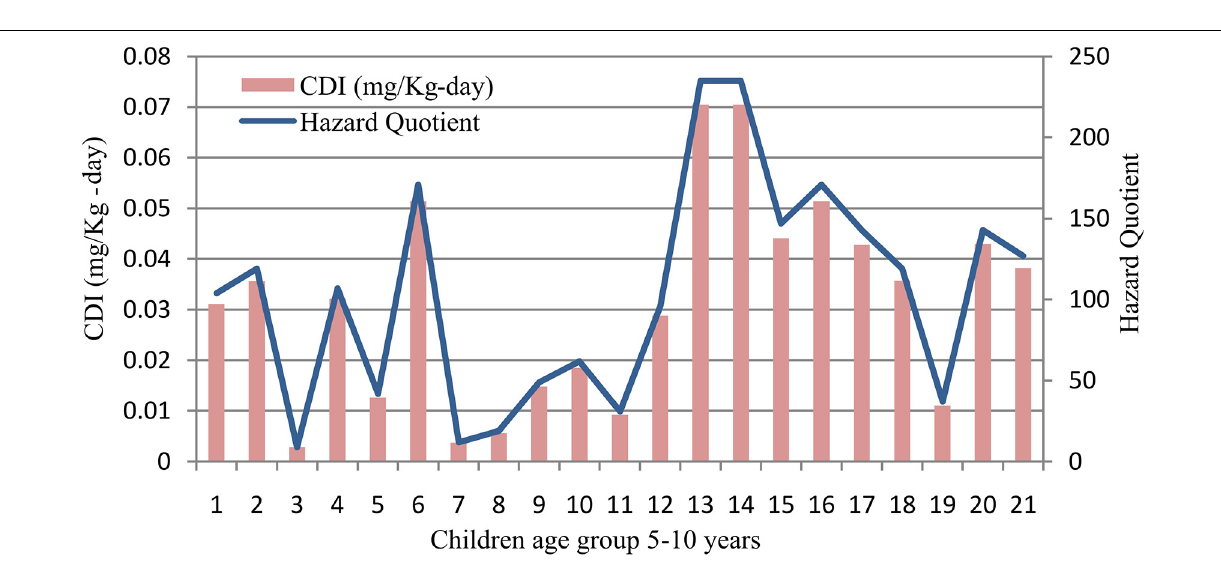
FIGURE 5 | Hazard Quotient (HQ) among children age group 5–10 years in Khap Tola. The HQ range of 9–235 is both greater than 1, indicating that children might confront more significant adverse non-carcinogenic health